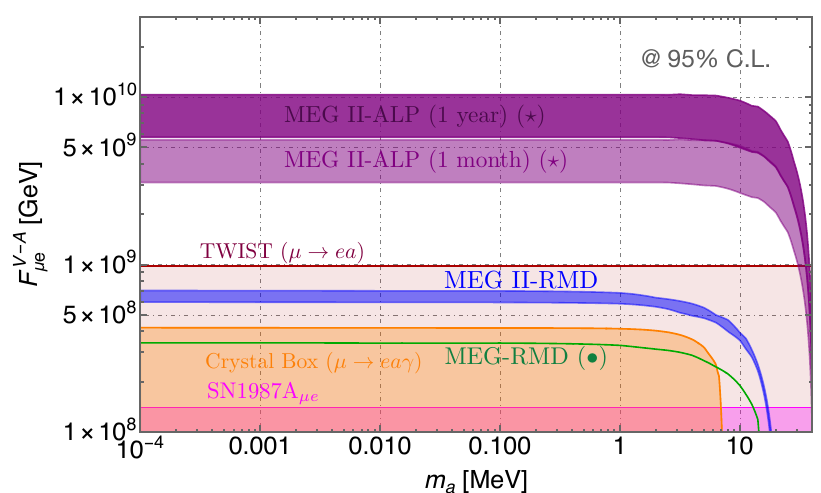
Figure 1 . 95% C.L. limits on F V − A . The green line is the expected bound from the parasitic µe analysis of MEG RMD data [14] (section 2.2). The blue band is the MEG II projection of the same parasitic analysis (section 2.3). The upper boundary of the band correspond to a 50% reduction of the RC background with respect to the MEG search [14]. The purple bands show the reach of the new hypothetical MEG II run with lower beam intensity and a dedicated trigger stream, with 1 month and 1 year of data taking (section 3). The upper (lower) limit of the reach corresponds to the lower (upper) limit in the determination of the trigger rate as detailed in figure 4. The orange shaded region is the most conservative Crystal Box bound derived in [8]. The dark red shaded region is the bound from the TWIST experiment on µ + → e + a [16]. The magenta shaded region is the supernova bound on the LFV coupling derived in